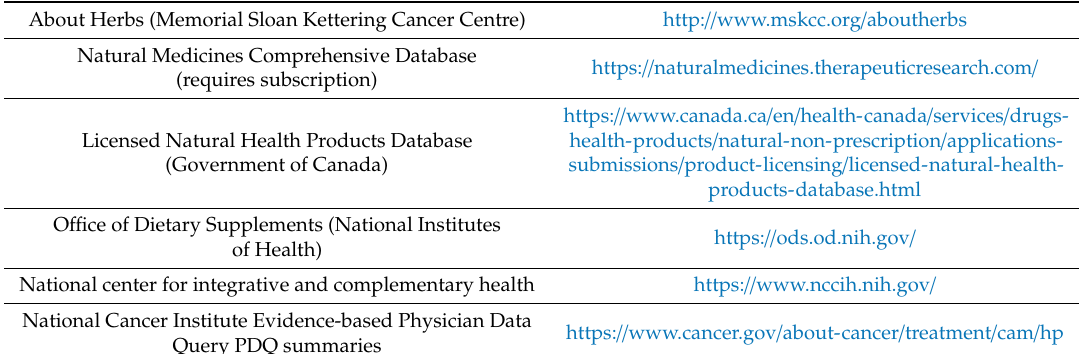
Table 1. Natural Health Product